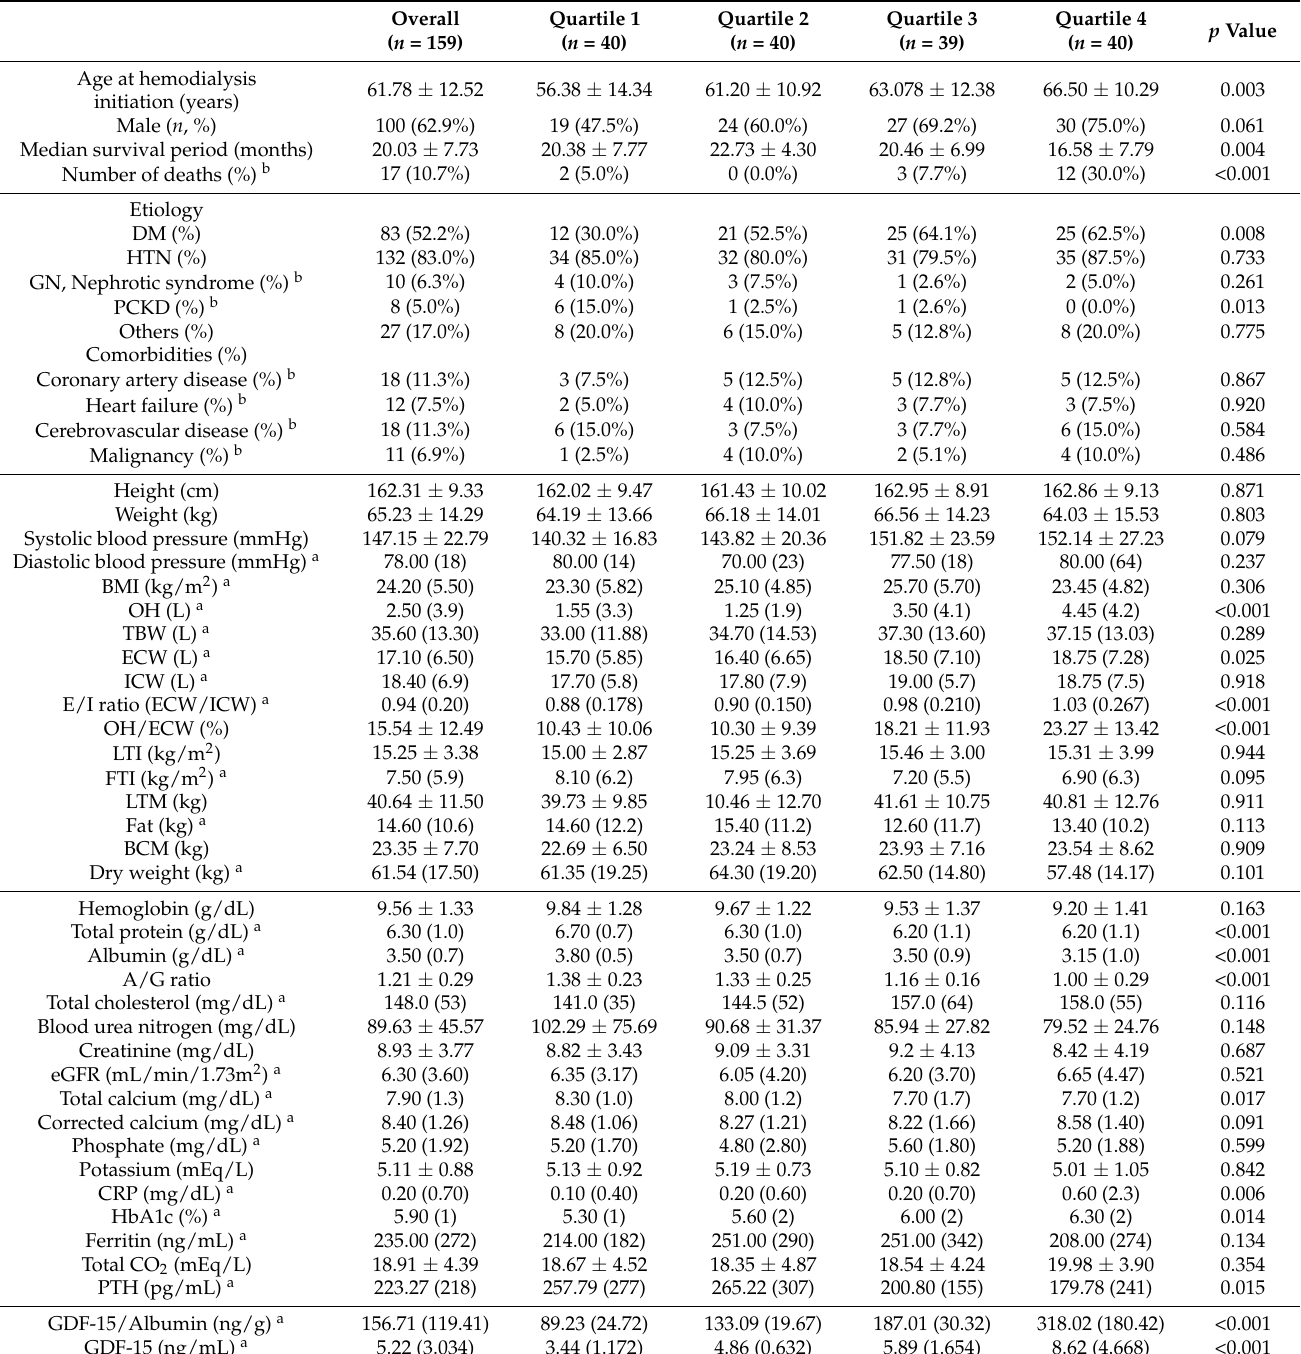
Table 1. Baseline characteristics of the study population according to quartiles of serum GDF-15/ albumin